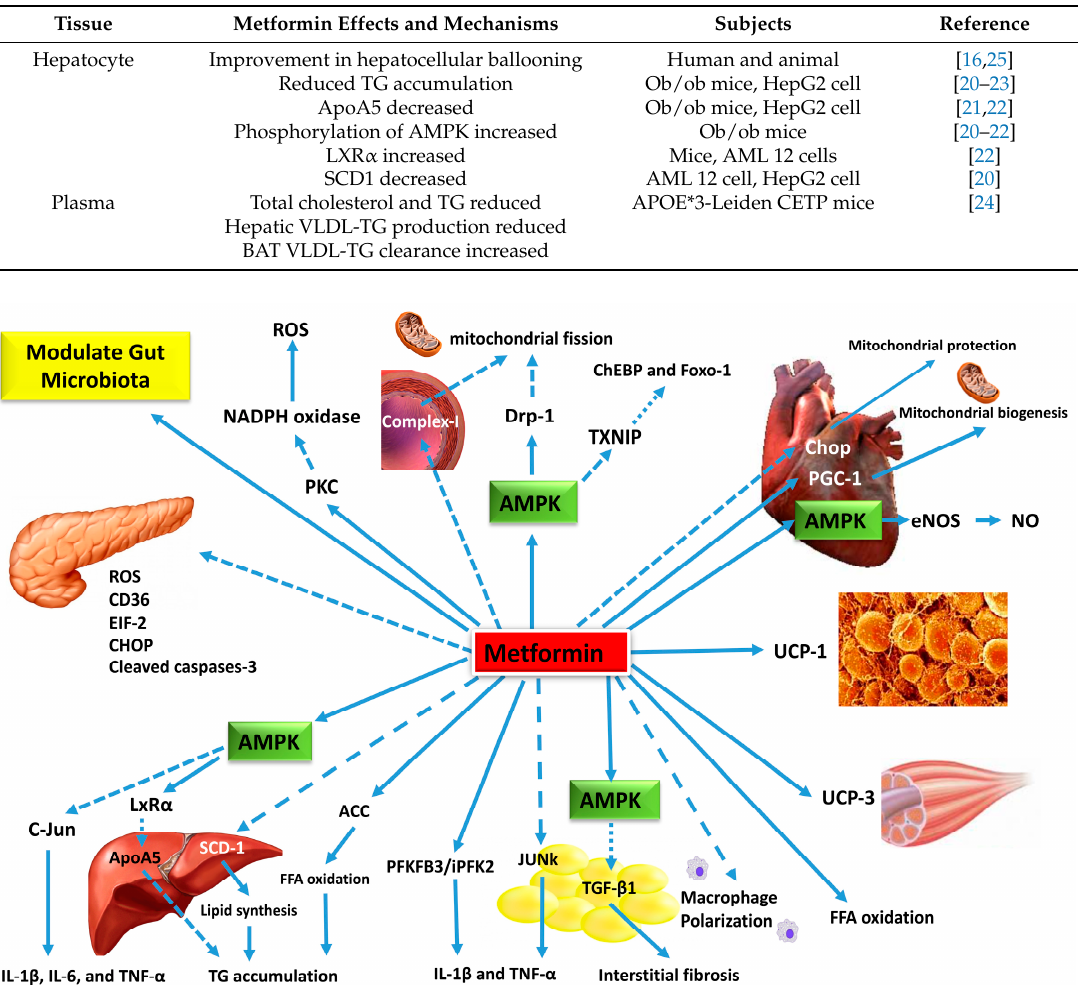
Table 1. Metformin improves nonalcoholic fatty liver disease (NAFLD).